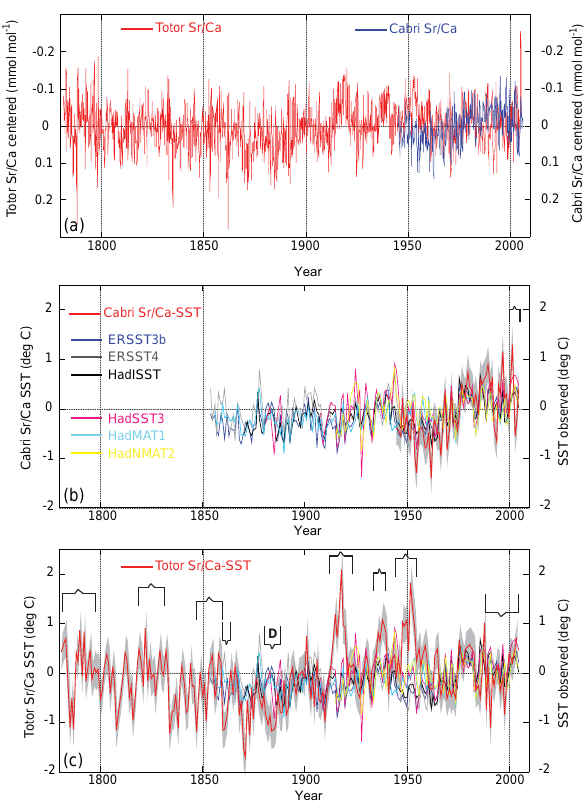
Figure 2. (a) Time series of monthly (thin solid lines) Sr / Ca anomalies (right Y axis inverted) relative to the 1961 to 1990 cli- matological mean for coral cores Cabri (blue), Totor (red) for the period 1781 to 2006. Annual mean time series of individual coral- derived SST (red line) (b) Cabri and (c) Totor compared to SST reconstructions: ERSSTv3b, ERSSTv4, HadISST, HadSST3, Had- MAT1 and HadNMAT2. See legend in (b) and (c) for colour code. For all time series we computed anomalies relative to 1961 to 1990. The uncertainty of mean annual coral Sr / Ca–SST anomalies is in- dicated by the grey envelope. Potential warm bias in coral SST is indicated by brackets, pointing up for warm and down for potential cool biases, respectively. Bracket with inset D marks core interval with diagenesis (cool